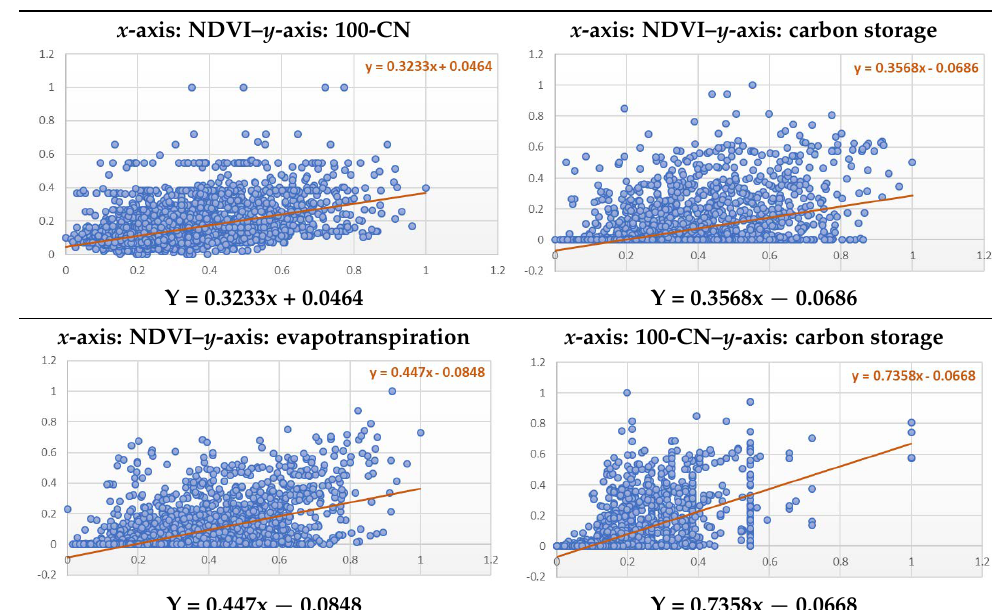
Table A4. Linear regression slopes: type